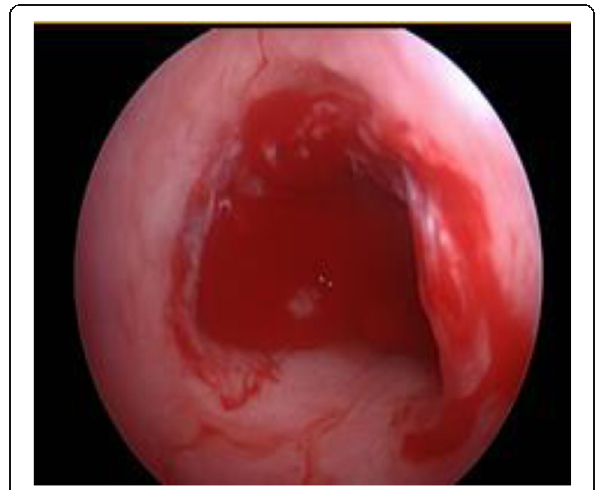
Fig. 2 Intraoperative transnasal endoscopy after CA reveals sizable residual adenoid tissues found at the posterior edge of the vomer (RPV) adjacent to the roof of the nasopharynx, and at the peritubaric region (PTR) on visualizing the RT choana. [LNW, lateral nasal wall; S, nasal septum]